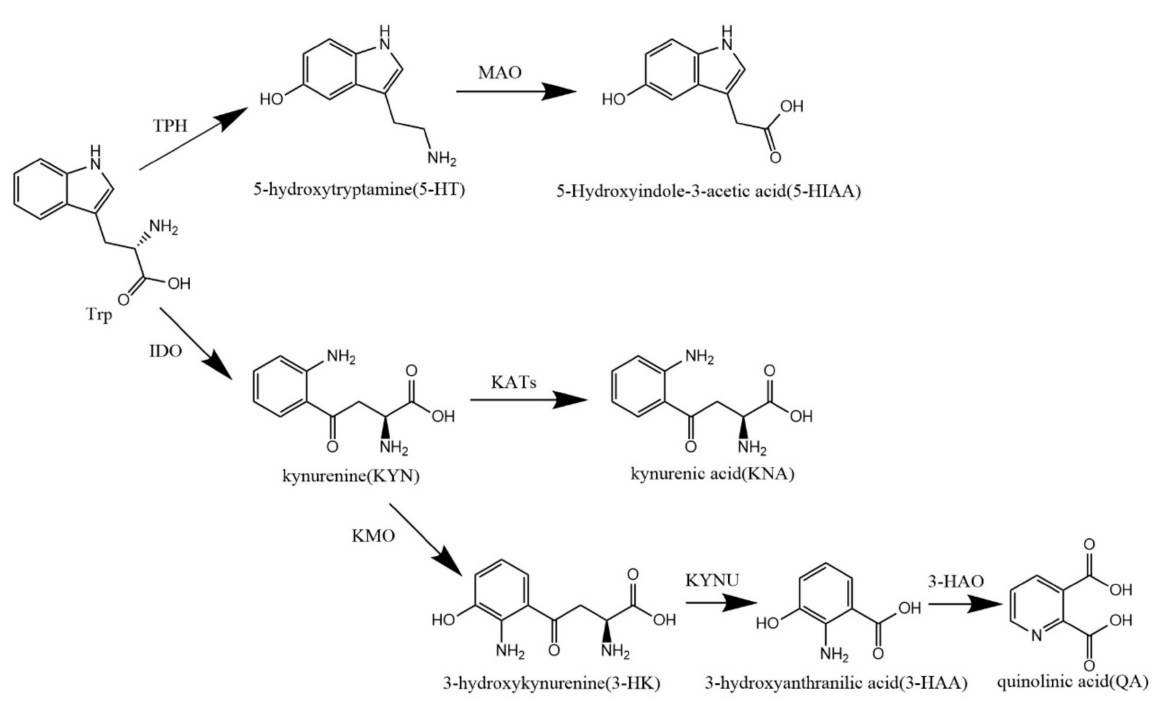
Figure 1. Trp metabolic